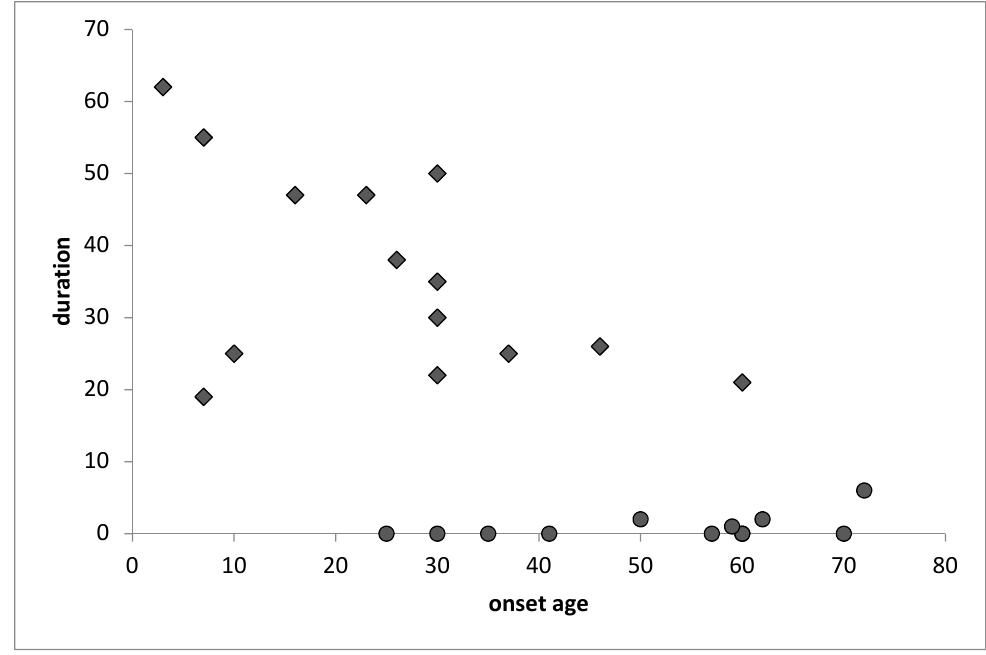
Figure 1. Relation between onset age and duration of the specific phobia disorder.